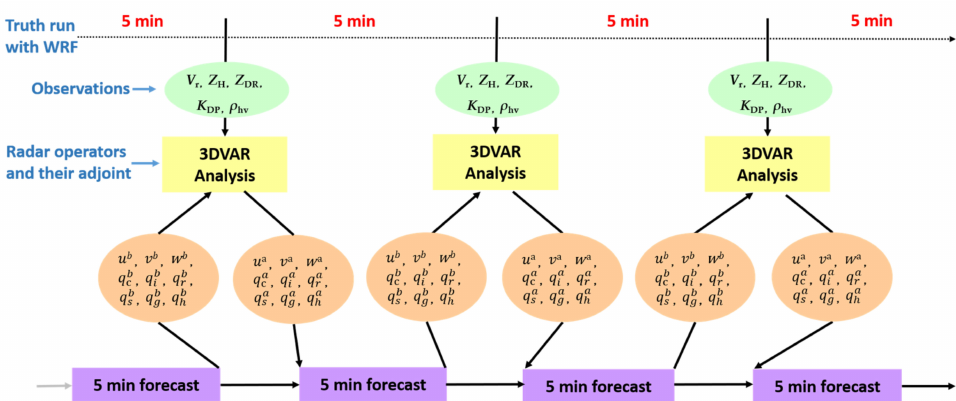
Figure 1. Illustration of DA and forecast cycles used for the idealized case study. Observations repre- sent the assimilated PRD including radar radial velocity, reflectivity, and all polarimetric variables simulated from the truth simulation output of the WRF run. The observations are assimilated by the 3DVAR system based on the background field of previous 5 min forecast